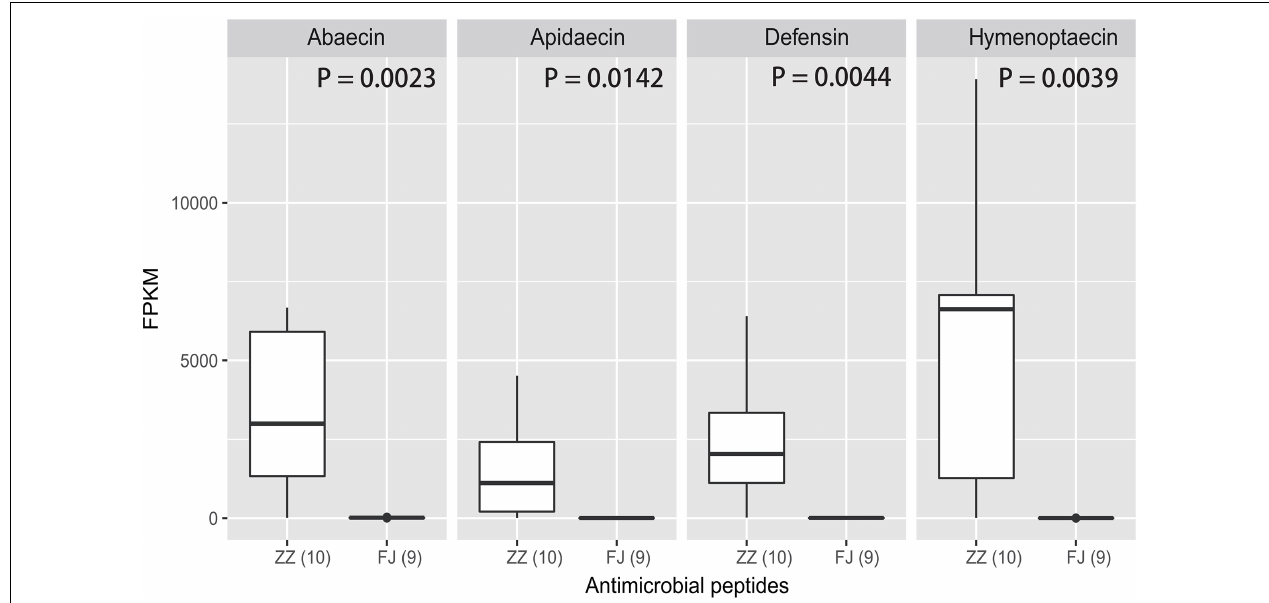
FIGURE 3 | The expression levels of the four AMPs in the treatment and the control. The four antimicrobial peptides are abaecin , apidaecin , defensin , and hymenoptaecin . FPKM is a criteria to represent the relative abundance of the four genes. The analysis of significant difference was conducted by t -test (abaecin: P = 0.0023; apidaecin: P = 0.0142; defensin: P = 0.0044; hymenoptaecin: P = 0.0039).